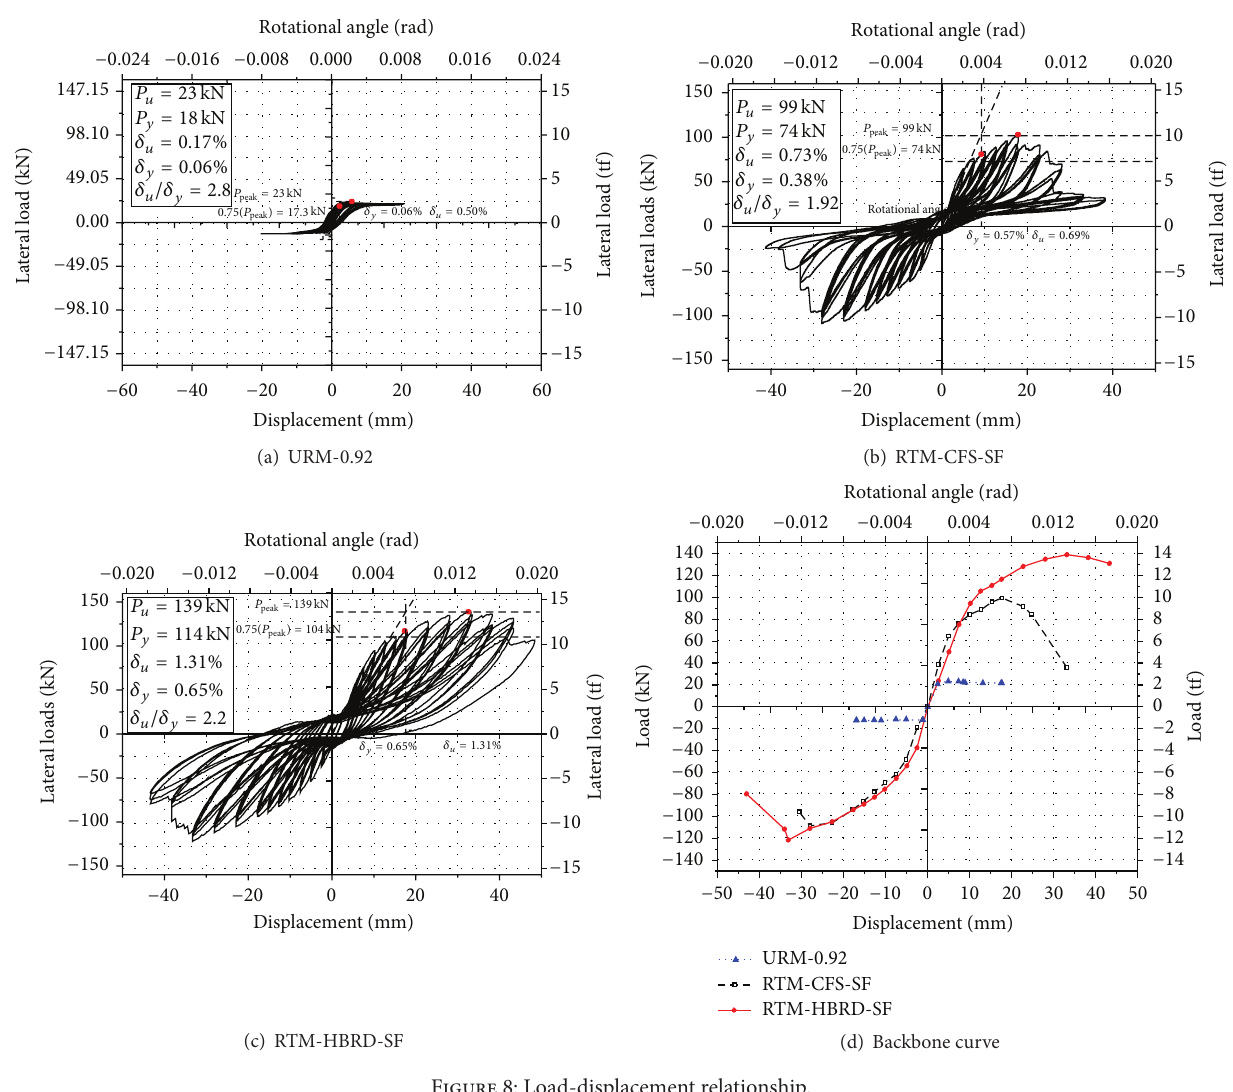
Figure 8: Load-displacement